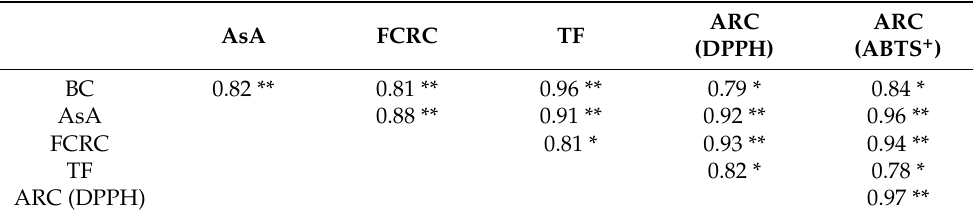
ARC ARC (DPPH) (ABTS + )